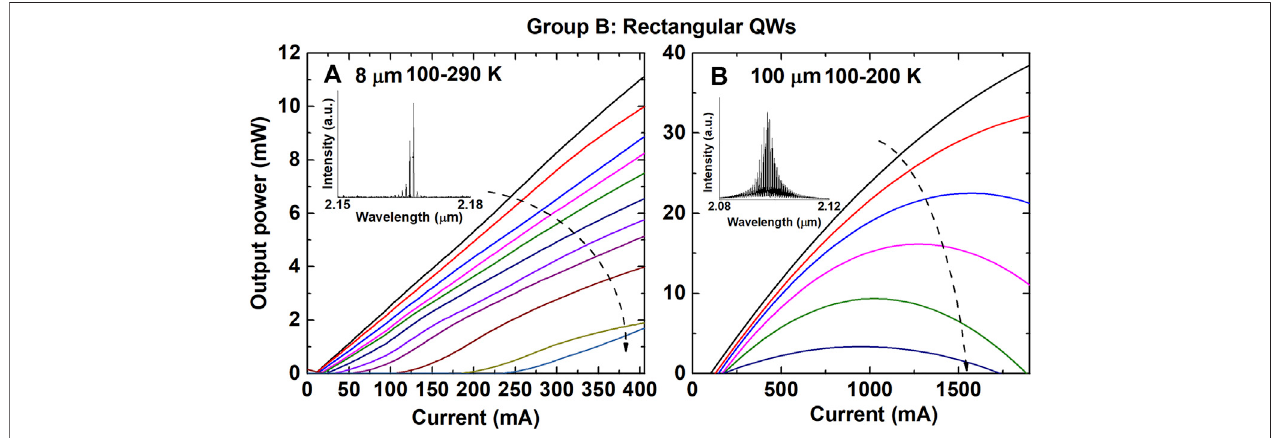
FIGURE3| Output power versuscurrentfor (A) the8- μ m ridgelaserfrom 100to290 K and (B) the 100- μ mridge laserfrom 100to200 Kfor groupB(rectangular QW) lasers. The insets show the output spectra at 290 and 200 K at 1.2 times of the threshold current for the two lasers, respectively. Note that the current ranges are 0 – 400 mA in (A) and 0 – 1900 mA in (B) ,